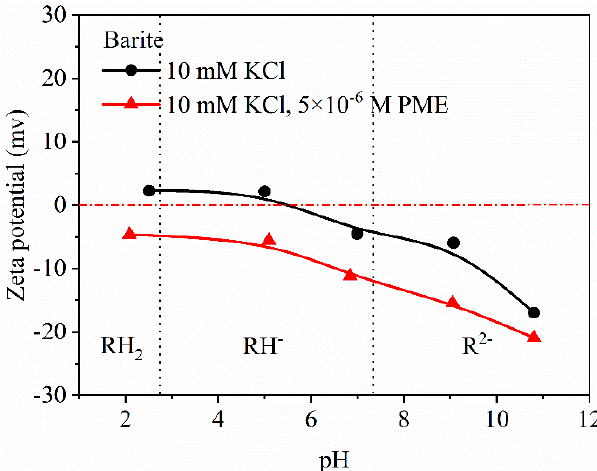
Figure 3. Barite zeta potential with and without the adsorption of lauryl phosphate (PME).